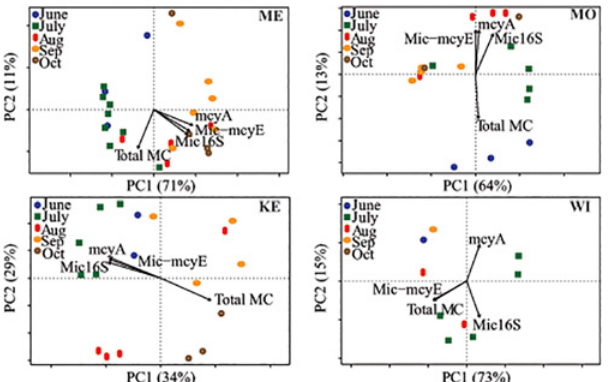
Fig 5. Canonical correspondence analysis (CCA) of cyanobacterial community composition (CCC) with toxin gene abundance and Total MC concentrations. The direction of the arrow indicates a positive correlation to those samples with the length representing the strength of correlation. In Lake Mendota, all toxin genes ( p < 0.001) and Total MC ( p < 0.05) were significantly correlated to CCC. In Lake Monona, only mcyA ( p < 0.01) was significantly correlated to CCC. No significant correlations existed for Lakes Kegonsa and Wingra. Axes percentages indicate that amount of variability explained by that axis. ME = Mendota, MO = Monona, KE = Kegonsa, and WI =